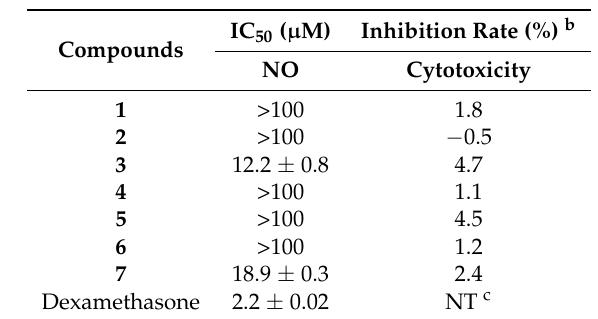
Table 2. Inhibitory effects on NO production against Raw 264.7 cells of compounds 1 – 7 and their cytotoxicities a .